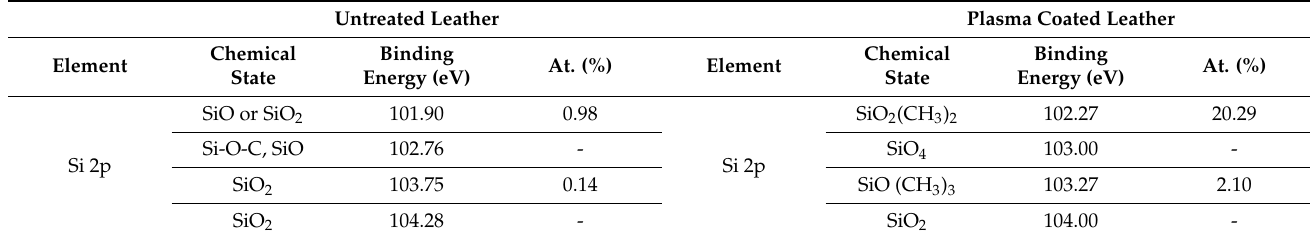
Figure 6. L*, a* and b* values for both untreated and plasma treated leather. -10-505 1015202530 35 L * , a * a n d b * v a l u e s CIELAB components Untreated leather Plasma coated leather